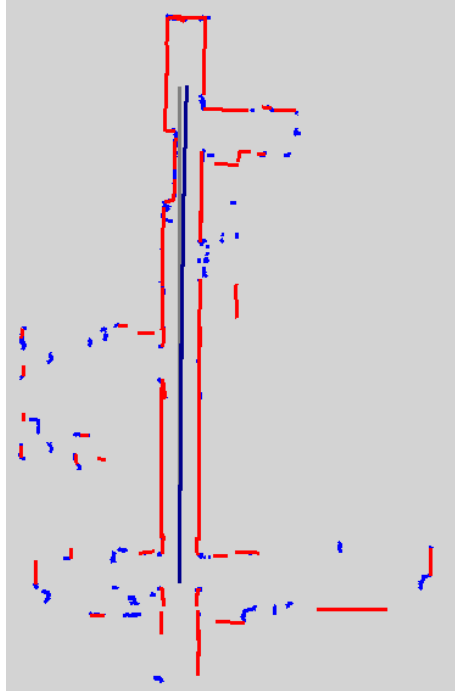
Figure 4. A larger map composed using the pre- sented processing system. Edges are colored in the same way as in Fig. 2d. Gray trajectory is acquired from odometry and dark blue one is an estimation of the true